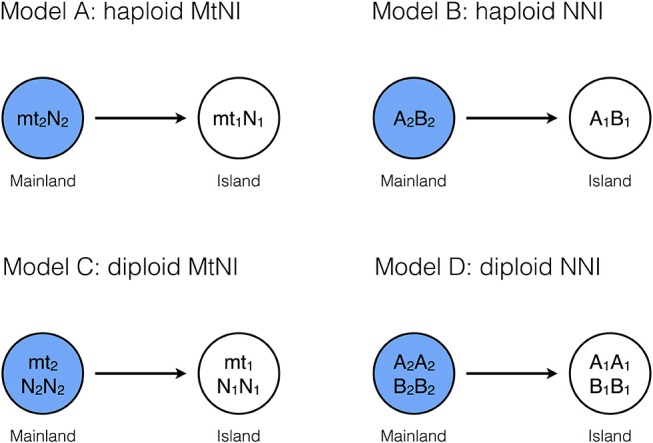
Basic model structures. Model A: The island population initially consists only of individuals of genotype mt1N1, whereas the mainland is homogeneous for genotype mt2N2 (haploid genetics). After secondary contact, mating incompatibilities can occur between the mitochondrial haplotype (mti) and the nuclear genotype (Nj). Model B: The island population initially consists of individuals of genotype A1B1, whereas the mainland is homogeneous for genotype A2B2 (haploid genetics). After secondary contact, nuclear-nuclear incompatibilities (NNI) between Ai and Bj reduce the number of offspring in intergroup matings. Model C: The island population initially consists of individuals of genotype mt1N1N1, whereas the mainland is homogeneous for genotype mt2N2N2 (diploid genetics). After secondary, mating incompatibilities can occur between the mitochondrial haplotype (mti) and the nuclear genotype (NjNk). Model D: The island population initially consists of individuals of genotype A1A1B1B1, whereas the mainland is homogeneous for genotype A2A2B2B2 (diploid genetics). After secondary contact, nuclear incompatibilities (NNI) between AiAj and BkBl can occur. For all four models, gene flow was measured by allele frequency changes at a neutrally selected marker locus that is unlinked to the incompatibility loci (Methods). Before secondary contact, the marker allele is at fixation on the mainland, but absent on the island.